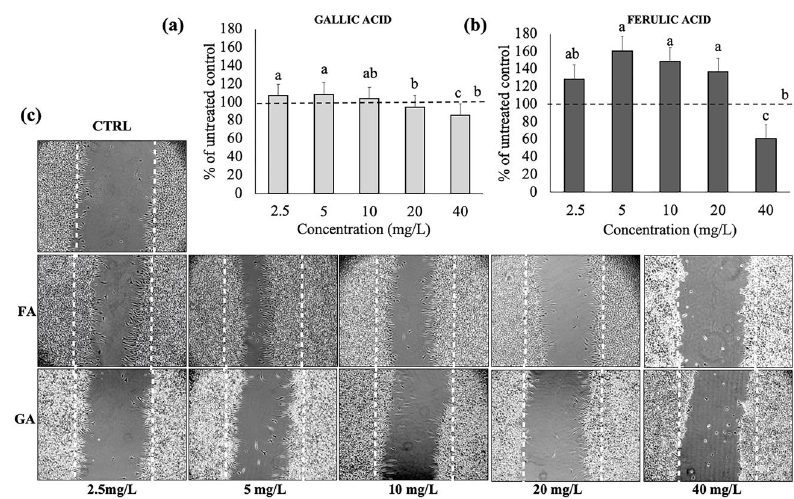
Figure 1. Gallic and ferulic acid effects on L929 mouse fibroblast proliferation and viability. L929 fibroblasts were treated with gallic and ferulic acids at 2.5, 5, 10, 20 and 40 mg/L, respectively. The MTT (3-(4,5-Dimethylthiazol-2-Yl)-2,5-Diphenyltetrazolium Bromide) assay ( a , b ) and viability assays ( c , d ) were performed 24 h after treatment. For caspase 3/7 analysis, L929 cells were treated with gallic and ferulic acid at the concentration of 20 µg/mL or diluent as the control. After 24 h, cells were stained with CellEvent™ Caspase-3/7 Green Detection Reagent ( e ). Data are expressed as a percentage of the control. Statistical analysis was performed and, between brackets, different letters indicate mean values that are significantly different at p < 0.05.